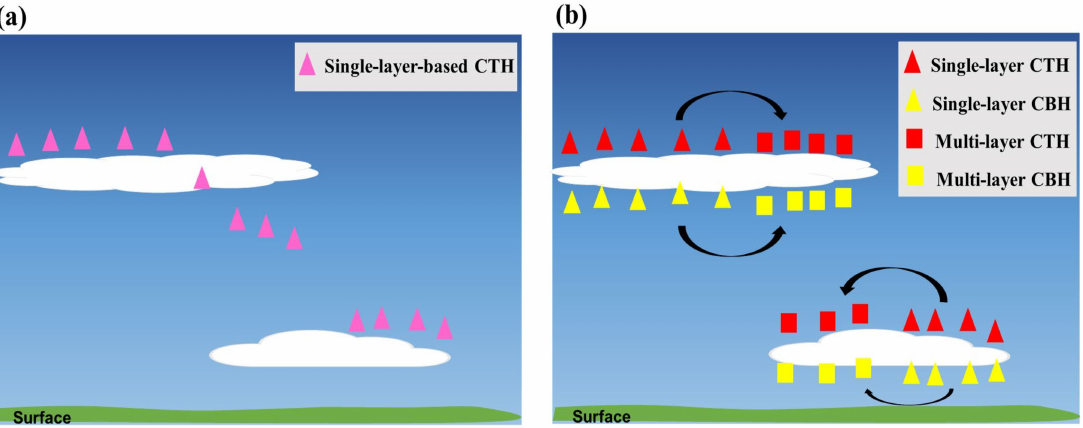
Figure 3. Cloud vertical structures characterized by ( a ) single-layer-based cloud-top height (CTH) retrievals and ( b ) CTH and cloud-base height (CBH) retrievals for both single- and multi-layer